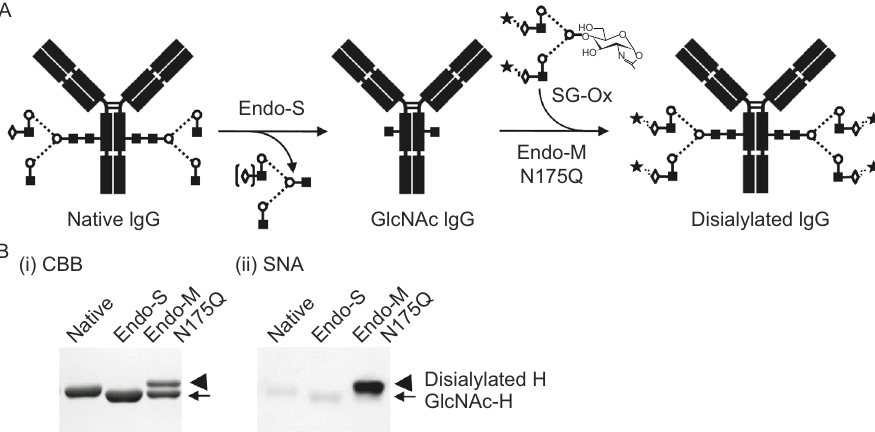
Figure 5. Glycosylation remodeling of IgG using Endo-S and Endo-M-N175Q. (A) Schematic representation of the chemoenzymatic glycoengineering method. SG-Ox, sialoglycan-oxazoline. (B) SDS-PAGE of the transglycosylation product of IgG. Mogamulizumab (1 mg) was deglycosylated with Endo-S (2,000 U, New England Biolabs) in 50 mmol/L acetate containing 5 mmol/L CaCl 2 (pH 5.5) and puri fi ed on a protein G column. The deglycosylated IgG (0.5 mg) was incubated with Endo-M-N175Q (100 mU, Tokyo Chemical Industry, Japan) and 1 mg of SG-Ox (Fushimi Pharmaceutical, Japan) in 50 μ L of 50 mmol/L sodium phosphate (pH 6.5) at 30°C for 2 h. CBB, Coomassie brilliant blue; SNA, Sambucus nigra